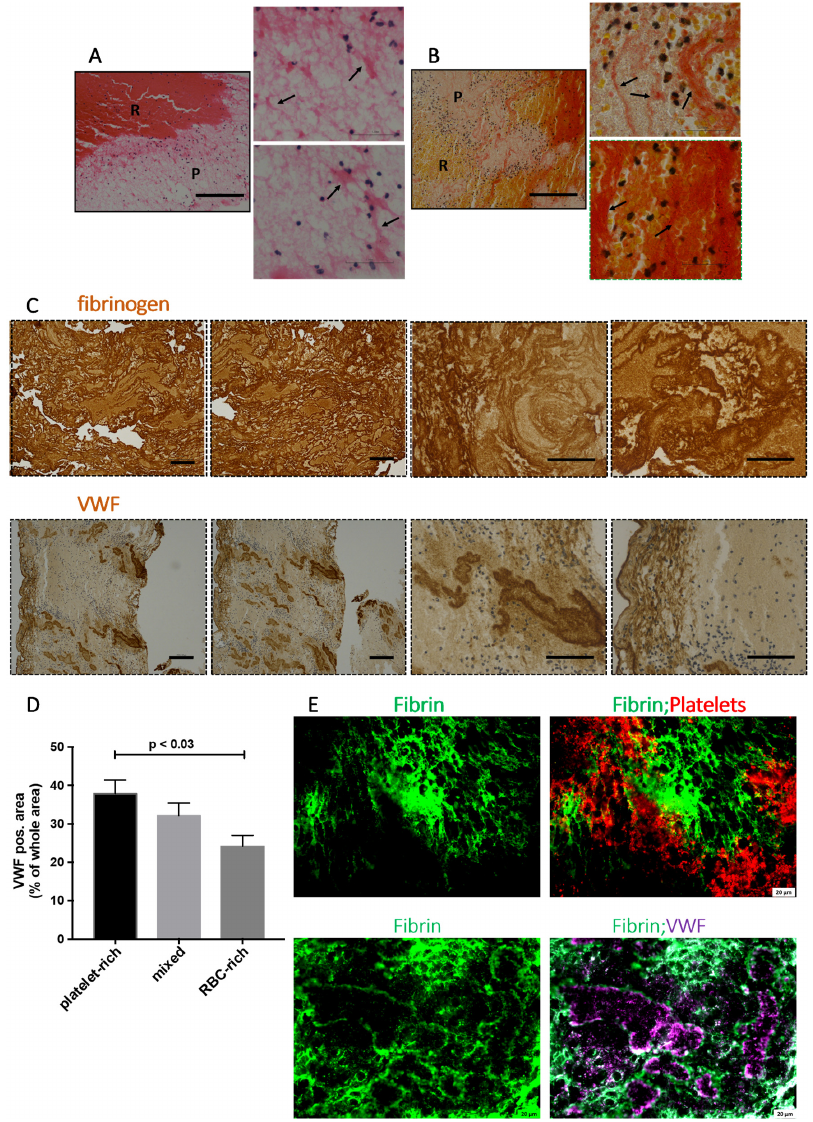
Figure 5. Platelet-rich areas show infiltrated platelets in dense fibrin networks lined with von Willebrand Factor (VWF). ( A ) Hematoxylin and Eosin (H&E) staining of AIS patient thrombi at low (left panel) and high (right panels) magnifications show profuse fibrin network (appearing light pink, black arrows) with heavily populated nucleated cells (blue) in platelet-rich (P) areas. Scale bars = 200 μ m. ( B ) Martius Scarlet Blue (MSB) staining of stroke thrombi at low (left panel) and high (right panels) magnifications show dense fibrin network (appearing red) in platelet-rich (P) areas. More nucleated cells (blue) are seen in the platelet-rich (P) areas. Scale bars = 200 μ m. ( C ) Immunohistochemical staining of retrieved stroke thrombi using antibodies specific to fibrin(ogen)